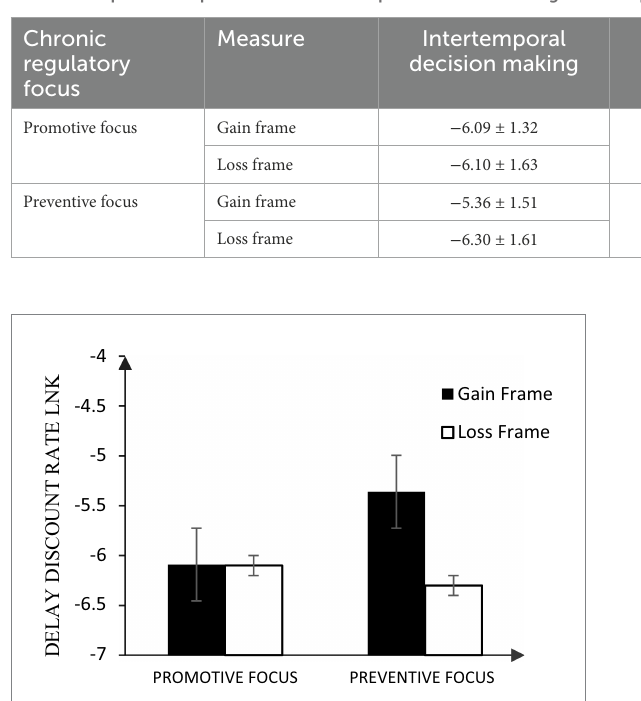
FIGURE 2 Effects of chronic regulatory focus on intertemporal decision making in the gain-loss frames.